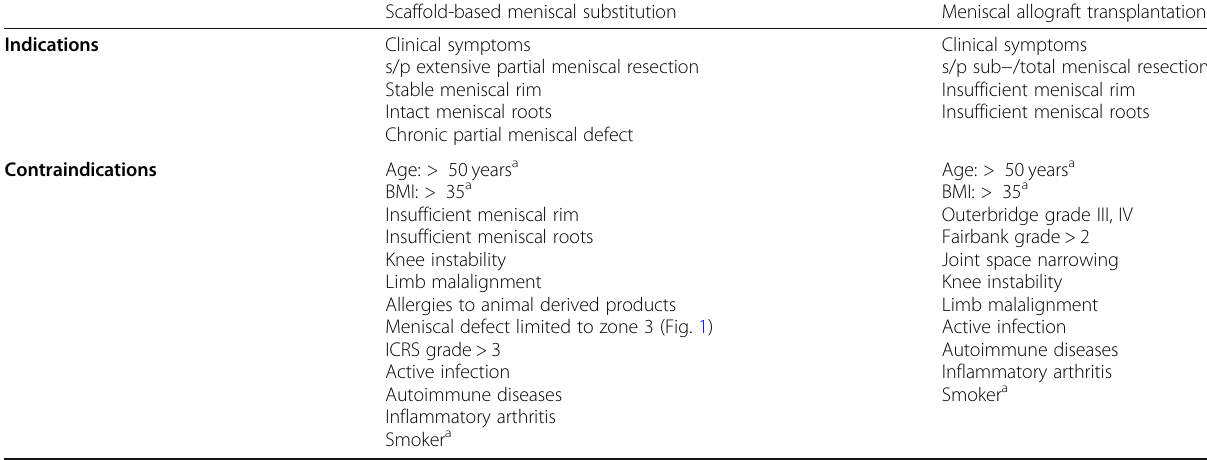
Table 2 Indications and contraindications for scaffold-based meniscal substitutes and meniscal allograft transplantation Scaffold-based meniscal substitution Meniscal allograft transplantation